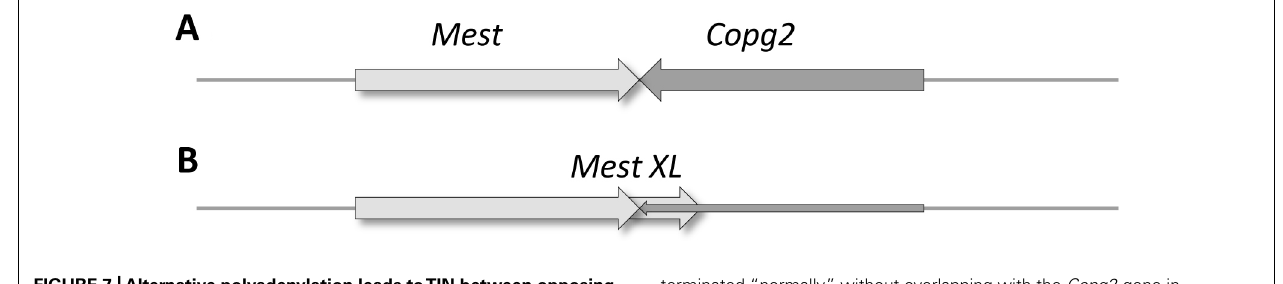
terminated “normally,” without overlapping with the Copg2 gene in embryonic liver cells (A) , whereas Mest transcription is continued within the Copg2 gene in neurons, thereby reducing the expression of this gene (B)